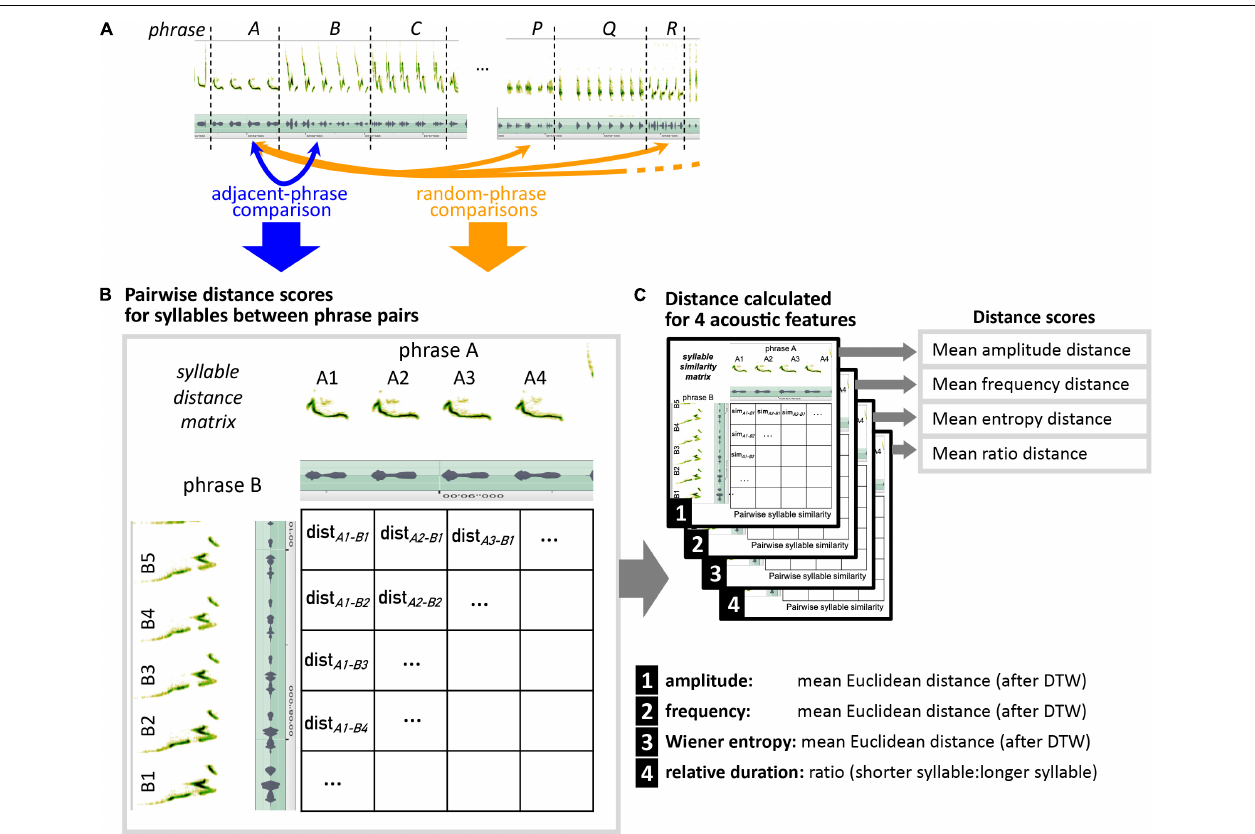
FIGURE 2 | Schematic explaining how pairs of adjacent phrases vs. pairs of random, distant phrases are compared, to determine whether adjacent-phrase similarity is higher than expected by chance. (A) Every phrase (e.g., here phrase A) is compared to its following phrase (B), and to 10 different non-adjacent phrases from outside of a 10-phrase range around phrase A. (B) For each phrase pair, all syllables of the first song phrase are being compared to all syllables in the second phrase in a pairwise fashion. (C) Distance scores are calculated separately for five acoustic features. For each feature, the distance score of a phrase comparison is the mean from all syllable